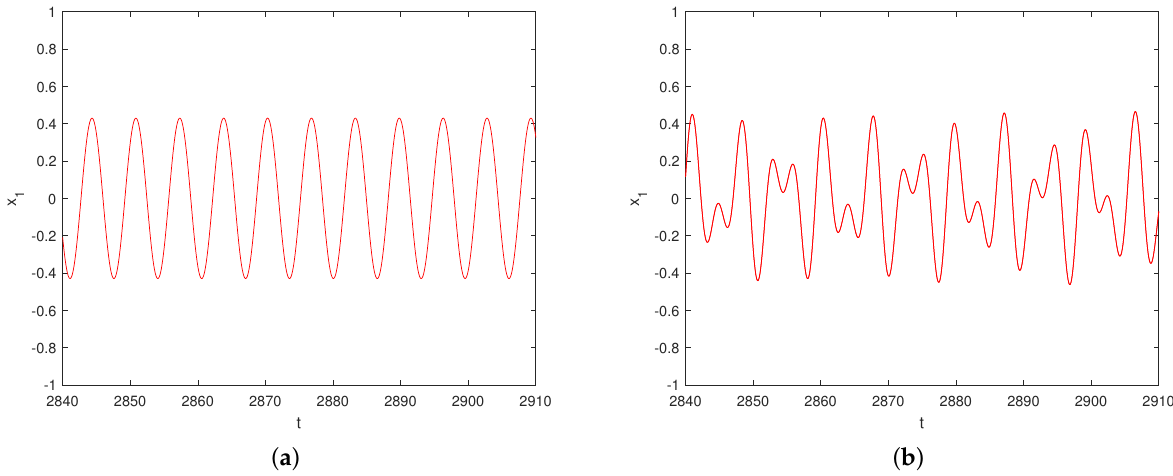
Figure 10. The time history diagram of approximate solutions. ( a ) Region II, ( b ) Region IV in Figure 6b,